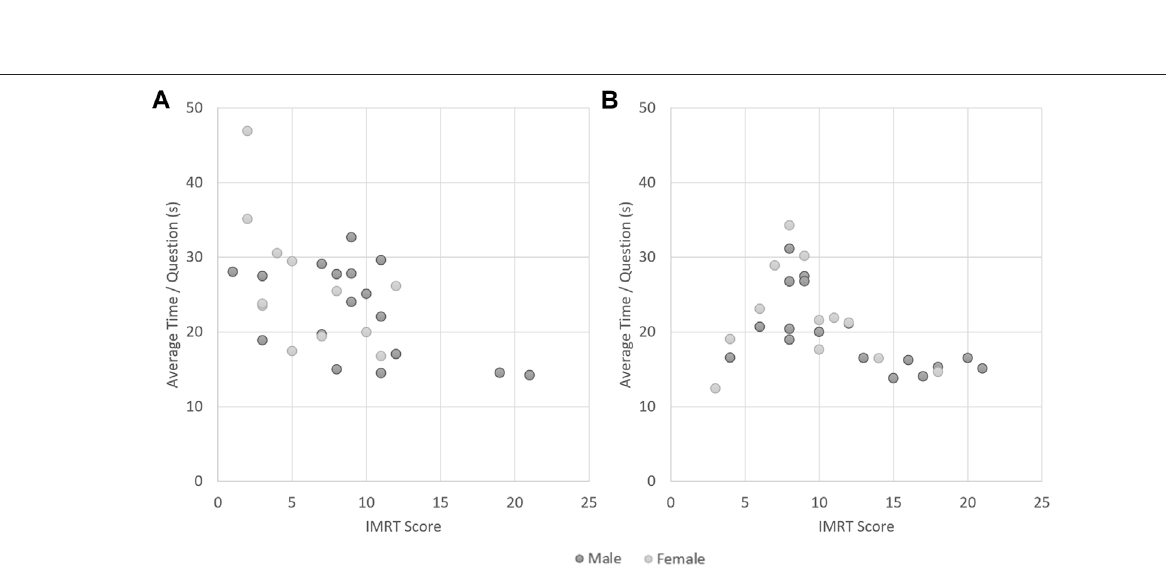
Frontiers in Virtual Reality |